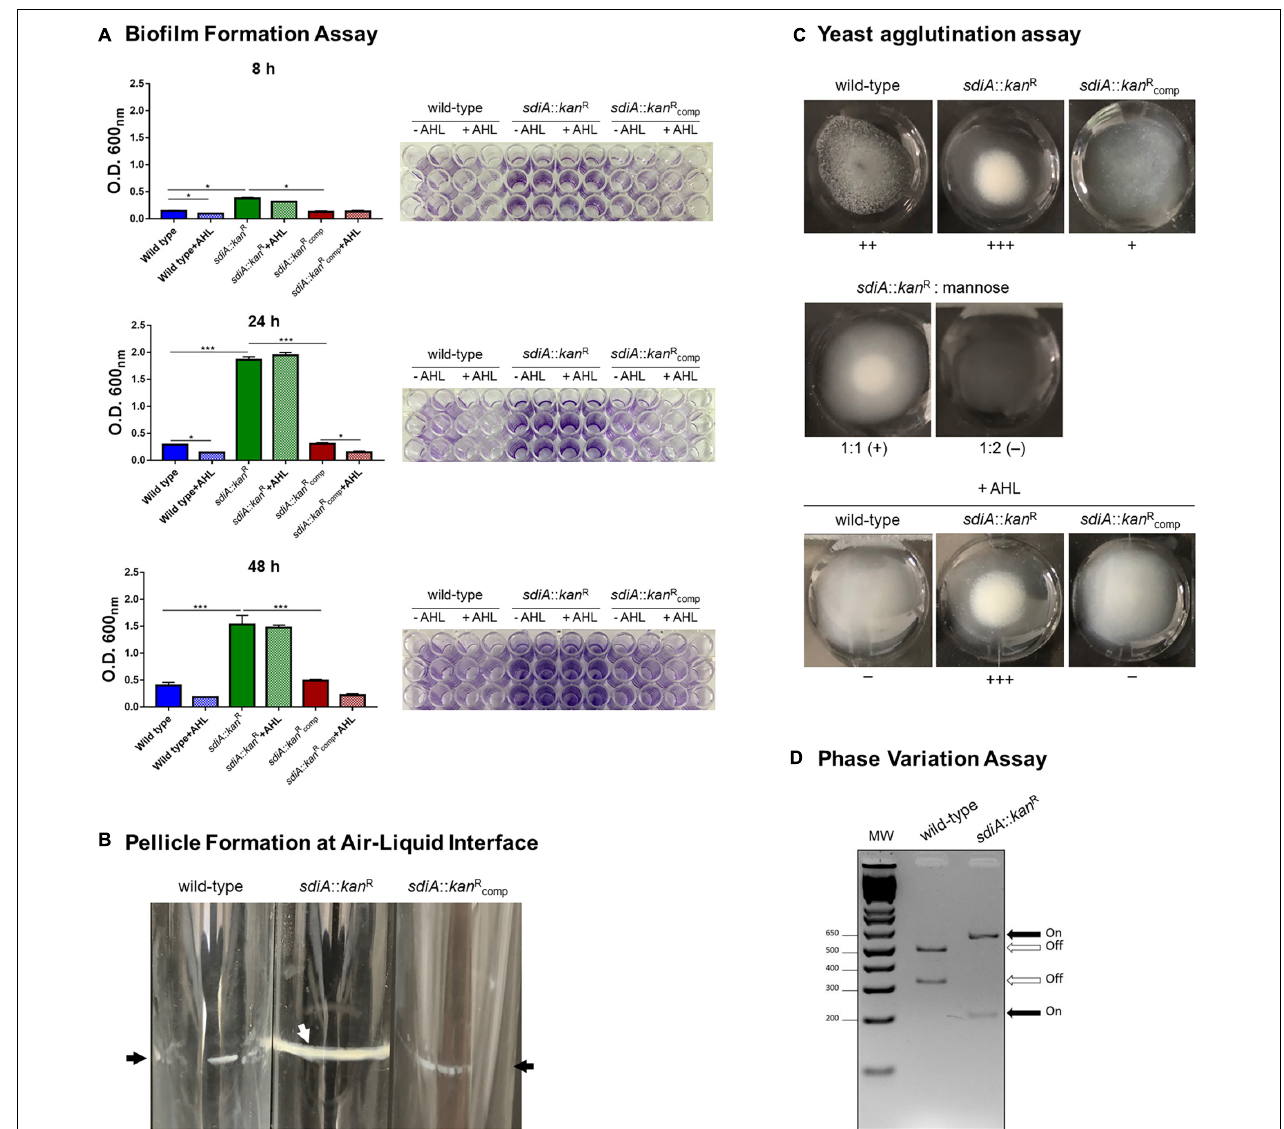
FIGURE 3 | K. pneumoniae deficient in SdiA presents enhanced biofilm formation, yeast cells agglutination, and production of type 1 fimbriae. (A) The biofilm formation assays showed that the mutant strain ( sdiA :: kan R ) forms more biofilm than the wild-type and complemented ( sdiA :: kan R comp ) strains. The addition of the AHL C8-HSL reduced the biofilm formed by the wild-type and the complemented strains at the indicated incubation times but did not affect biofilm formation by the mutant strain. For this assay, the strains were incubated at 37 ◦ C in 96-well microtiter plates under static condition for 8, 24, and 48 h, and then stained with crystal violet. The biofilm-associated crystal violet was solubilized and measured at O.D. 600 nm . Error bars represent the standard deviation. Statistically significant differences between the strains were analyzed using ANOVA (* p < 0.05; *** p < 0.001). The 96-well plates of each biofilm formation assay are shown to the right of the respective graphs. (B) The pellicle formation at the air-liquid interface assays showed that K. pneumoniae mutant strain presents thicker pellicle formation when compared to the wild-type and complemented strains. For this assay, strains were cultivated for 72 h at 37 ◦ C under shaking conditions. Black arrows indicate thin pellicle structure formation by the wild-type and complemented strain, while the white arrow indicates the formation of thick pellicle by the mutant strain. The images are from an individual representative experiment. (C) The yeast agglutination assays revealed that the mutant strain agglutinated yeast cells with more intensity than the wild-type strain. The absence of agglutination of yeast cells by the mutant strain in the presence of mannose confirms that the agglutination was mediated specifically by type 1 fimbriae. The addition of AHL reduced the agglutination by the wild-type and the complemented strains but had no effect on the agglutination of the yeast cells by the mutant strain. For yeast agglutination assays, cultures of the bacterial strains at O.D. 600 nm of 0.6 were mixed with Saccharomyces cerevisiae cells, and the intensity of the agglutination was digitally documented. The images are from an individual representative experiment. (D) The phase variation assays showed the promoter region of the fim gene cluster at ON orientation in the mutant strain and at OFF orientation in the wild-type strain. For this assay, the fimS element, which contains the promoter region of the cluster fim , was PCR amplified using DNA extracted from the wild-type and mutant strains cultured in LB broth to O.D. 600 nm of 0.6. The amplicons were cut with Hin fI and the digested fragments were resolved by electrophoresis on agarose gels. The fimS element at ON orientation results in fragments of 212 and 605 bp, whereas at OFF orientation results in fragments of 321 and 496 bp. The image is from an individual representative